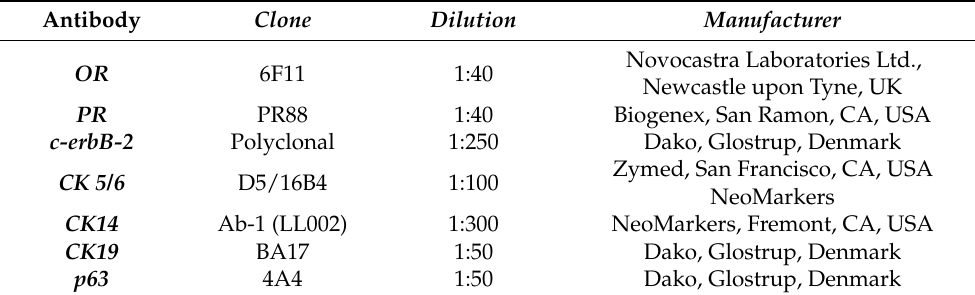
Table 1. Primary antibodies used to assess molecular phenotype of the investigated feline mammary carcinomas.